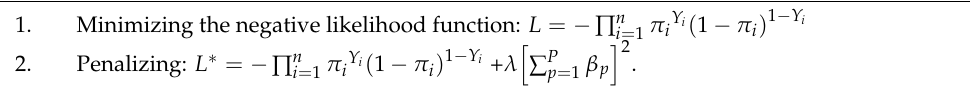
Algorithm 3. Ridge Logistic